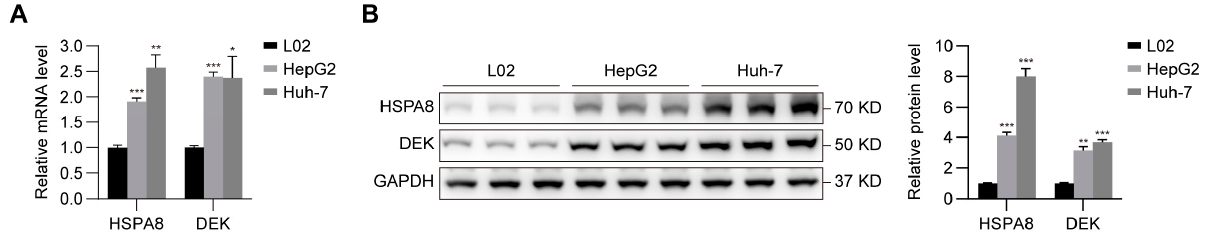
Figure 7. Verification of the expression of HSPA8 and DEK in HCC cells using qRT-PCR ( A ) and western blotting ( B ). The results are representative of three separate experiments. * p < 0.05, ** p < 0.01, *** p < 0.001.